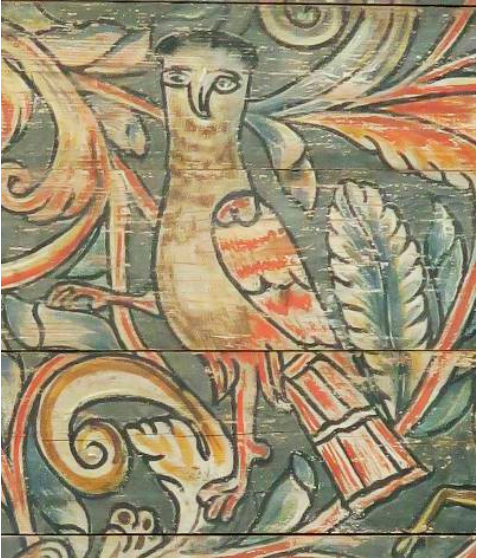
Figure 6. An owl painting on a wooden panel. Horb, Synagogue, 1735. Jerusalem, The Israel Museum. Photograph: Zvi Orgad, 2017. Used by permission.